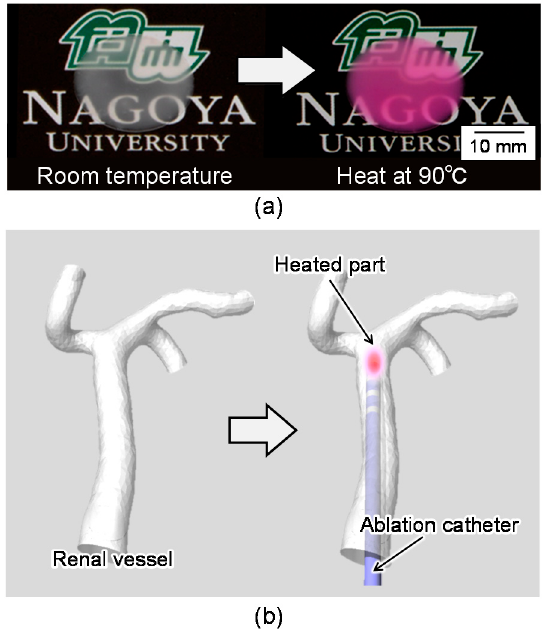
Figure 1. Concept of blood vessel model with temperature-indicating function. ( a ) Demonstration of color change of the composite material; ( b ) Concept of blood vessel model with temperature-indicating function.